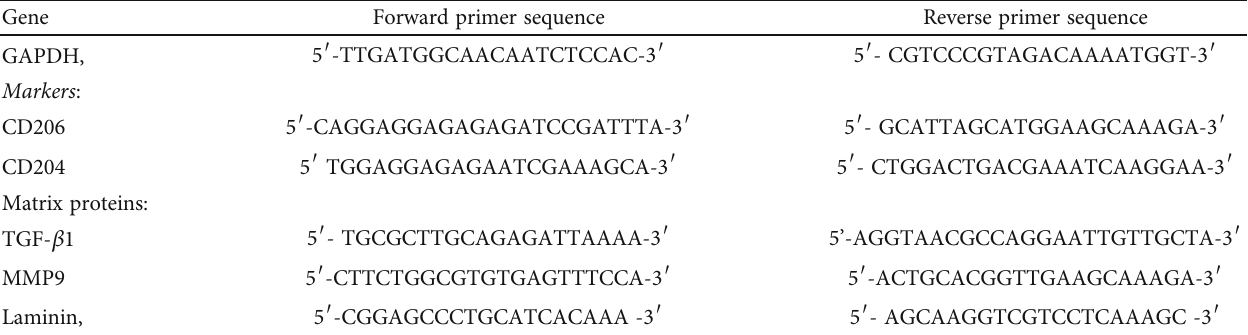
Table 1: Primer sequences used to assess gene expression by qRT-PCR.